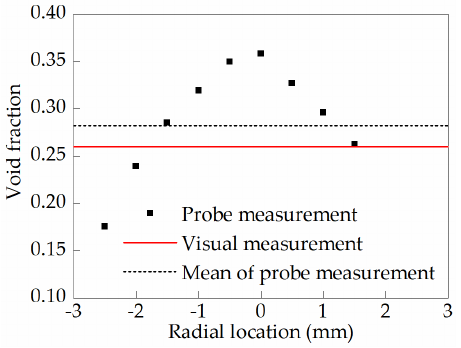
Figure 10. Void fraction from probe and visual measurement.